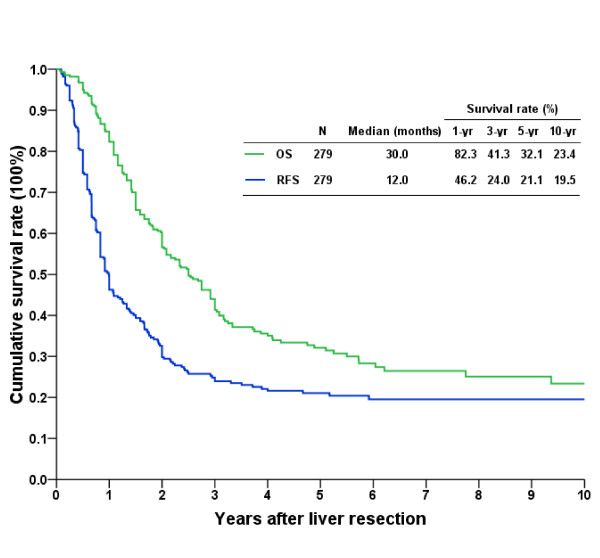
Long-term cumulative recurrence-free survival (RFS) and overall survival (OS) curves of patients undergoing liver resection for hepatic metastasis from colorectal cancer.